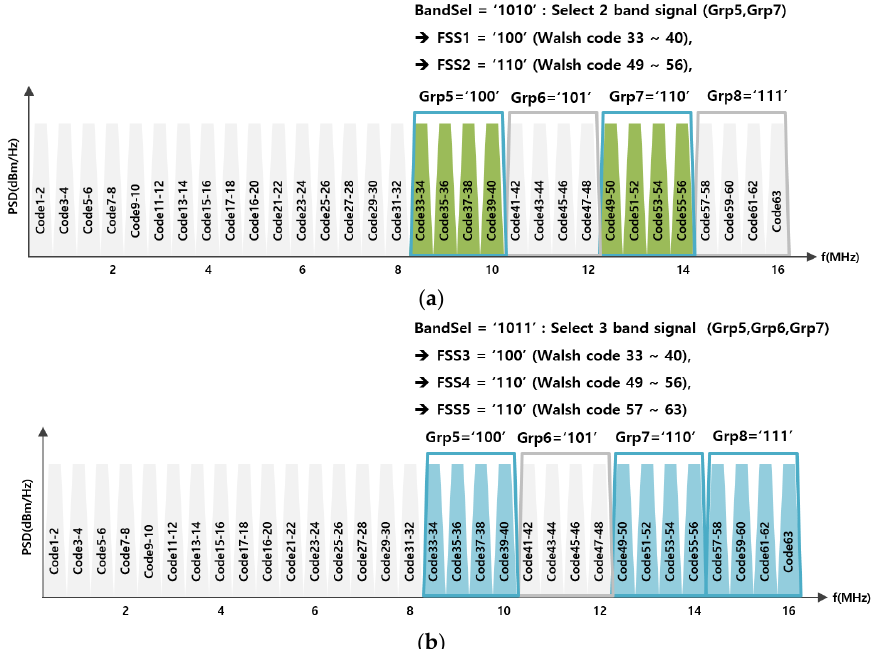
Figure 4. Example of selecting the frequency bands used in the CEHBC system: ( a ) Two frequency band and Walsh code range chosen when using the low-rate frequency selective (FS) spreader; ( b ) Three frequency band and Walsh code range chosen when using the High-rate FS spreader.